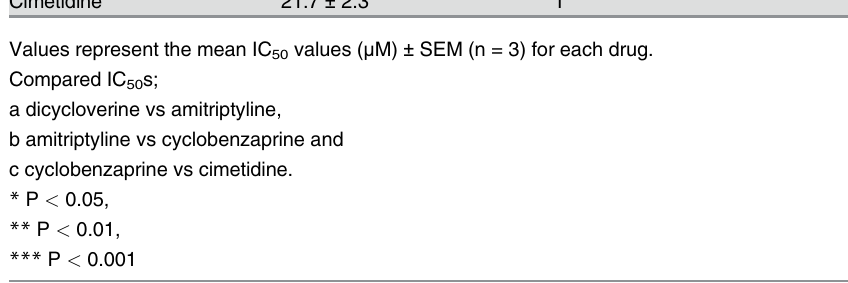
Values represent the mean IC 50 values ( μ M) ± SEM (n = 3) for each